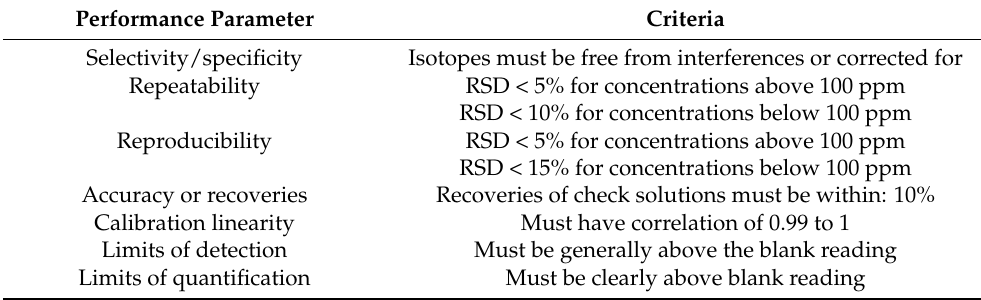
Table 3. Criteria for REE method